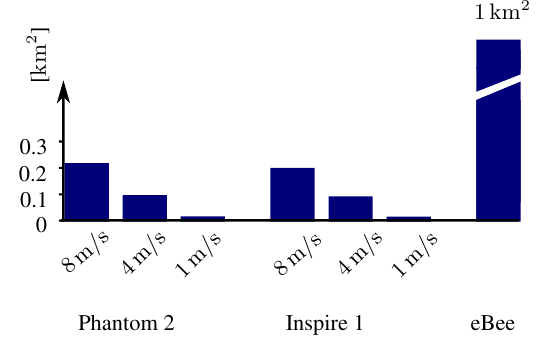
Figure 10: Approximate estimation of the maximum surface that can be covered using a single battery charge by the UAVs at dif- ferent speeds.